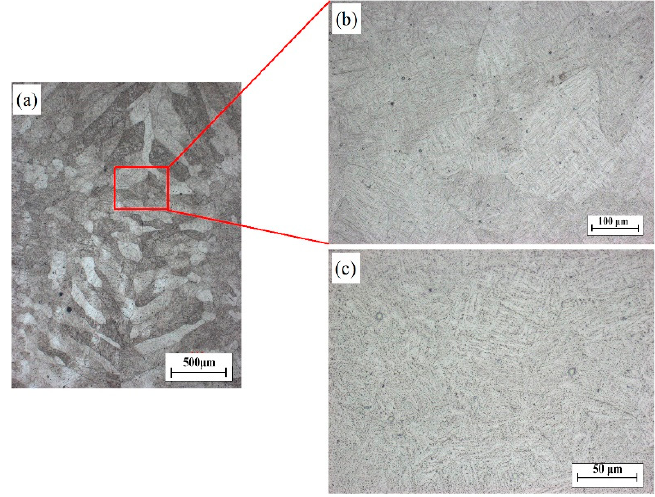
Figure 5. Magnification view of fusion zone and heat-a ff ected zone of W5 joint: ( a ) fusion zone and heat-a ff ected zone; ( b ) high-magnification scanning electron microscope image of the rectangular region in ( a ); ( c ) high-magnification scanning electron microscope image of ( b ).